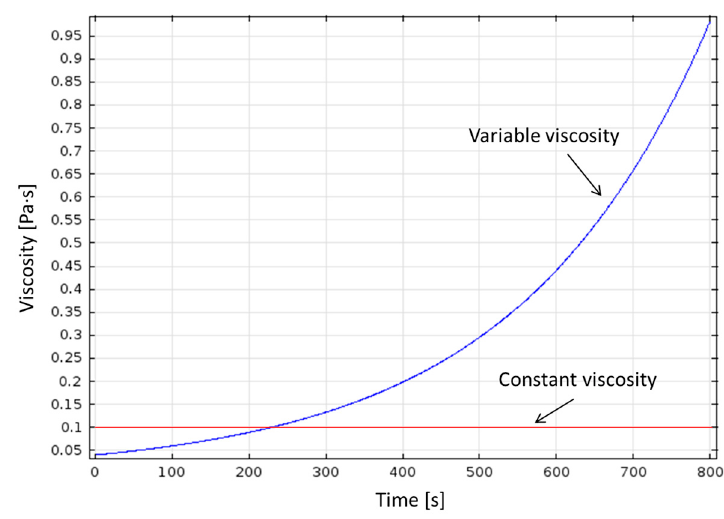
Figure 8. Viscosity curves for the filling simulations of the first hood geometry.